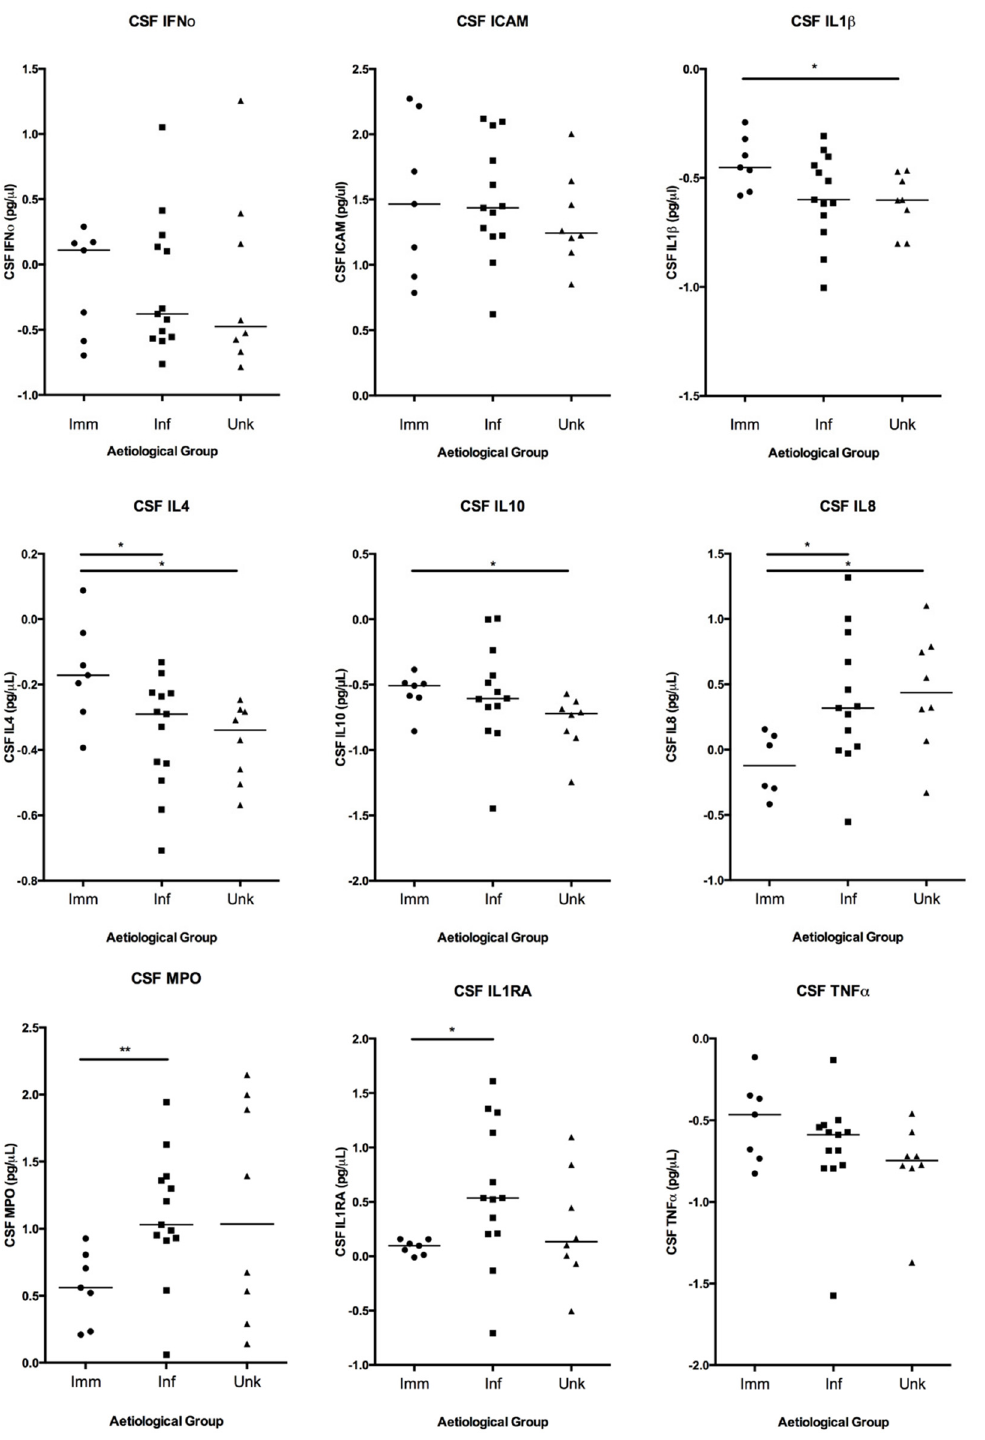
Fig 3. CSF concentrations of mediators identified in patients with encephalitis of immune-mediated, infectious and unknown aetiology.